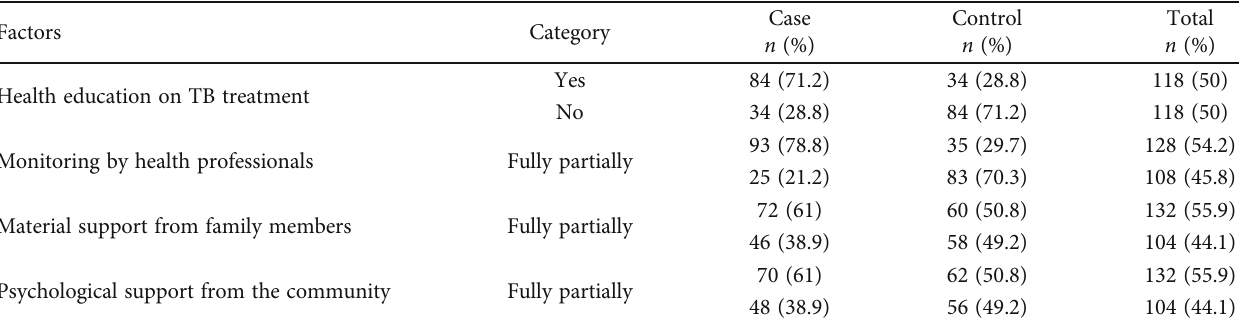
Table 4: Supervision and support-related factors of study participants in Debre Markos town public health facilities, Northwest Ethiopia, 2020.